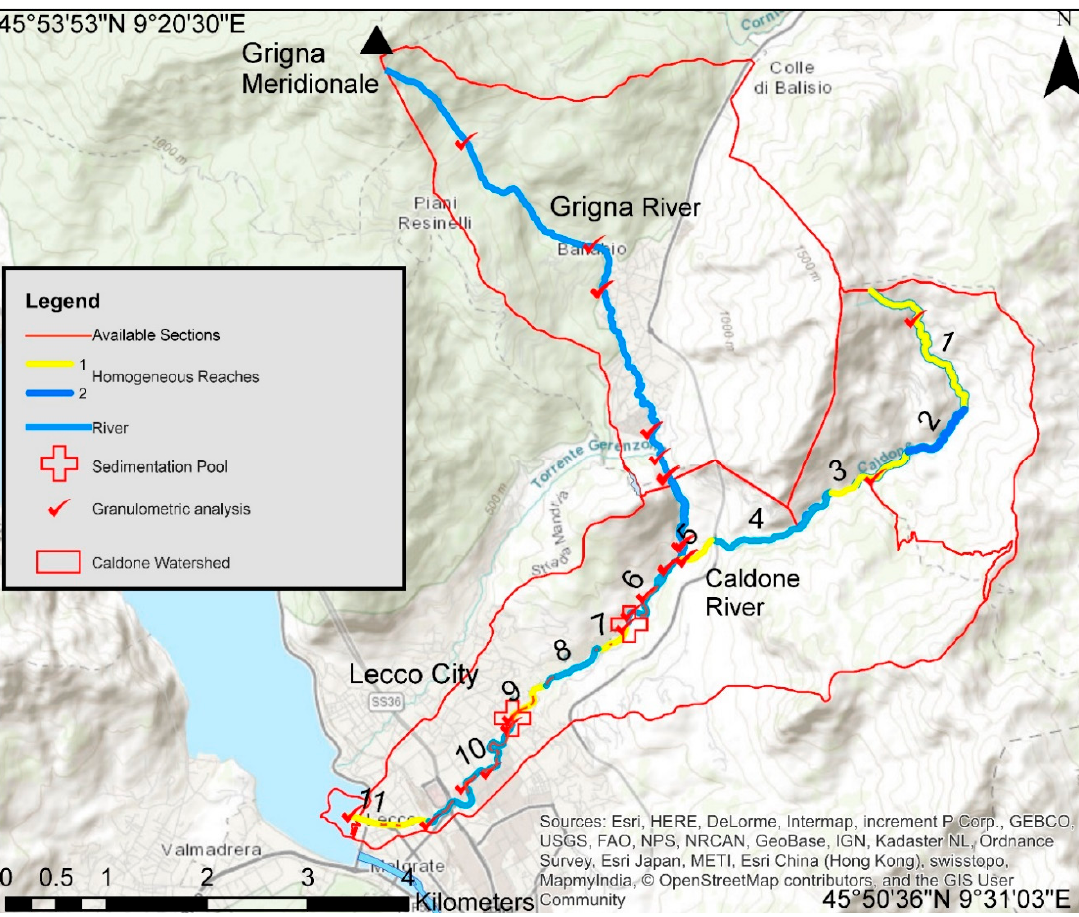
Figure 2. Caldone River watershed and main interest points. Tracers were added in segments 6, 7, and 11. A rain gauge is present in segment 11. Level gauges are present in segments 7 and 11. Part of segment 11 flows in a culvert. Red crosses stand for the two sedimentation pools, while red ticks represent granulometric analysis spots.